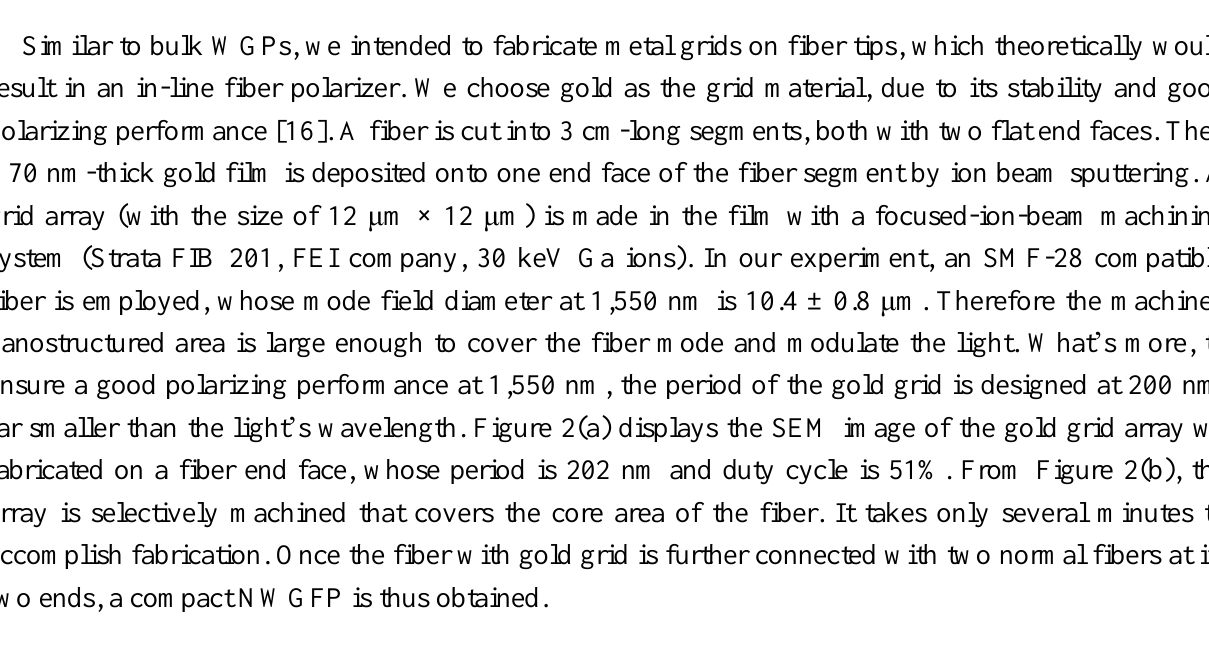
Figure 2. (a) SEM image of part of the gold grid array fabricated on a fiber tip; (b) SEM image of a whole fiber tip with a gold grid array at its core